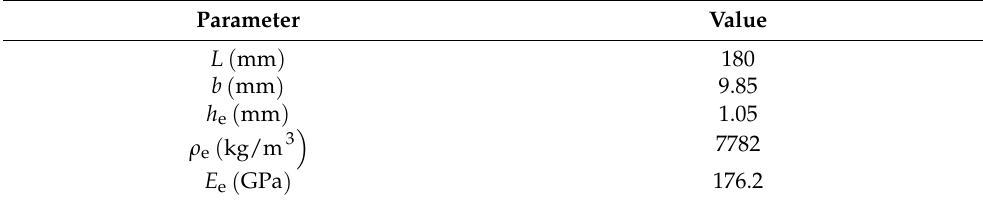
Table 1. Geometry of the beam and properties of the elastic material